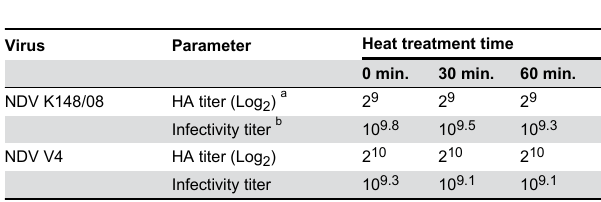
Table 2. Hemagglutination activity and embryonated egg infectivity titer of NDV K148/08 strain after heat treatment at